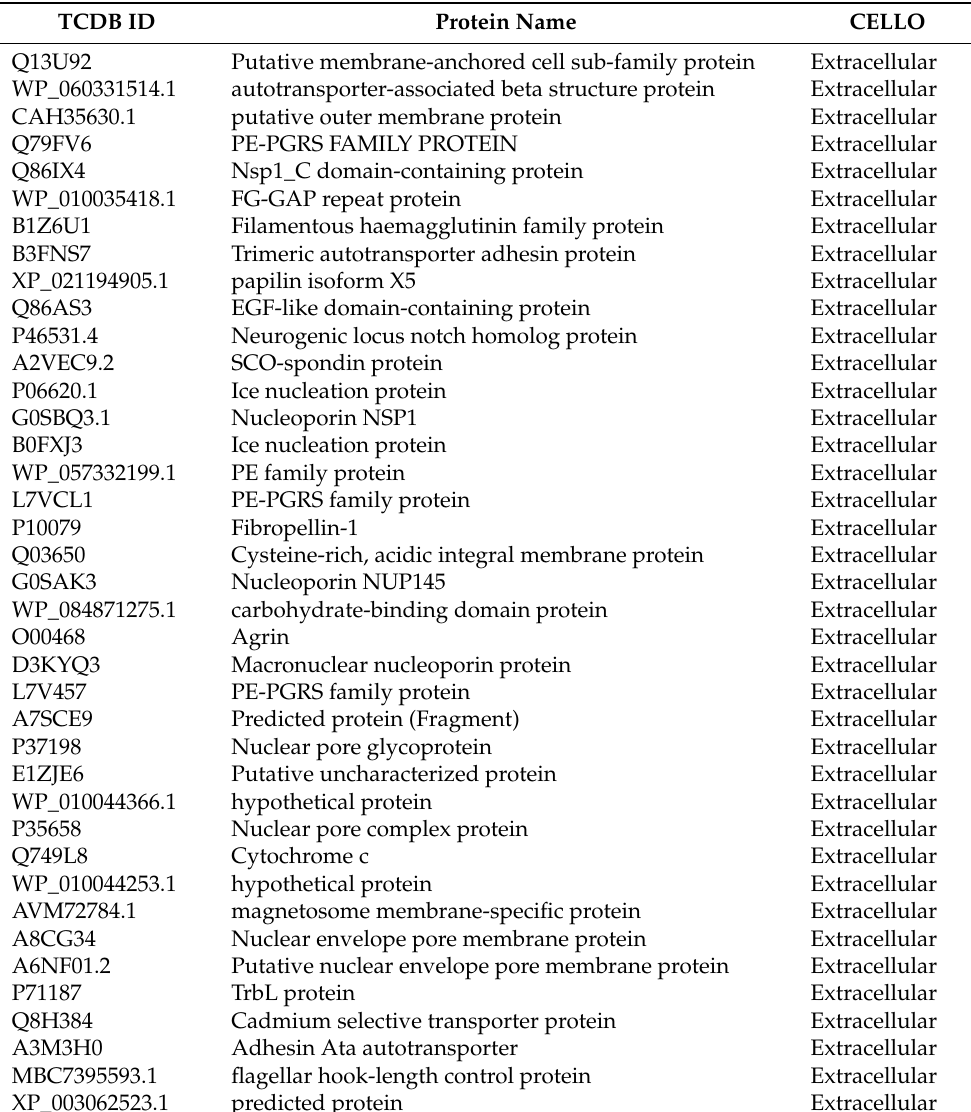
Table 1. Interpretation of cellular and sub-cellular localization through CELLO of predicted trans- porter proteins by